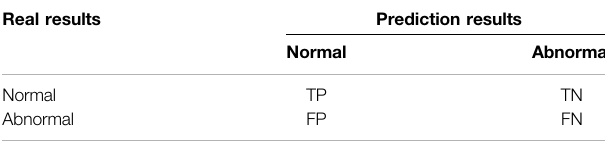
TABLE 2 | Confusion matrix of classi fi cation results.